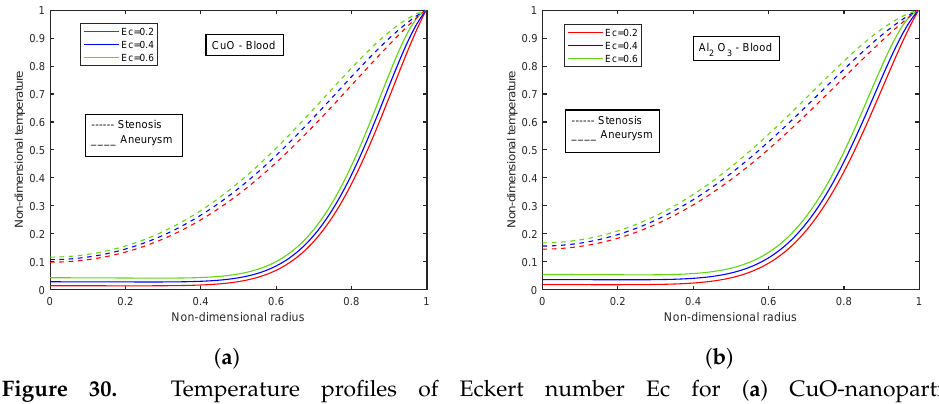
Figure 30. Temperature profiles of Eckert number Ec for ( a ) CuO-nanoparticles, ( b ) Al 2 O 3 -nanoparticles.